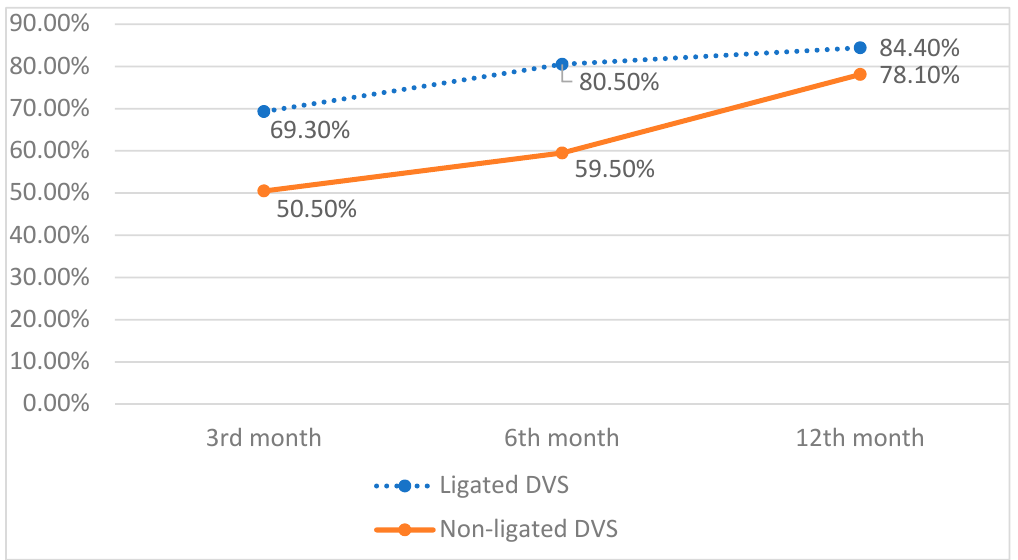
Table 6. Evaluation of incontinence grade in 12 months follow up.